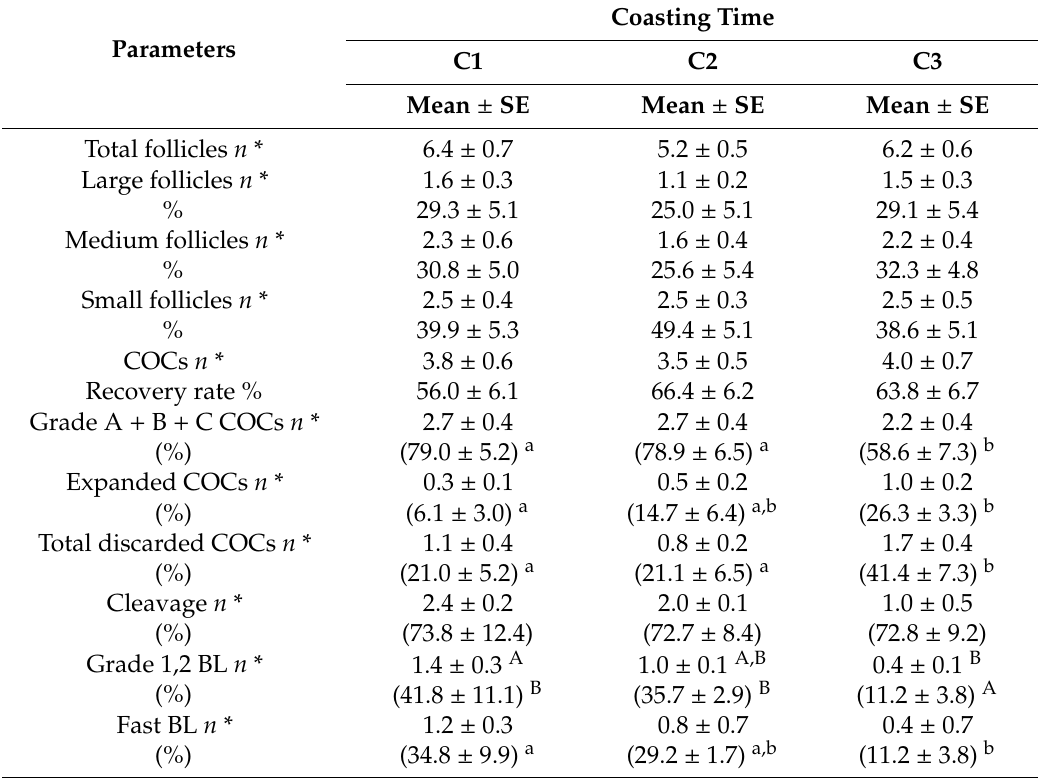
Table 2. E ff ect of 28–32 h (C1), 40–44 h (C2), and 64–68 h (C3) coasting times on follicular population, oocyte quality, and developmental competence